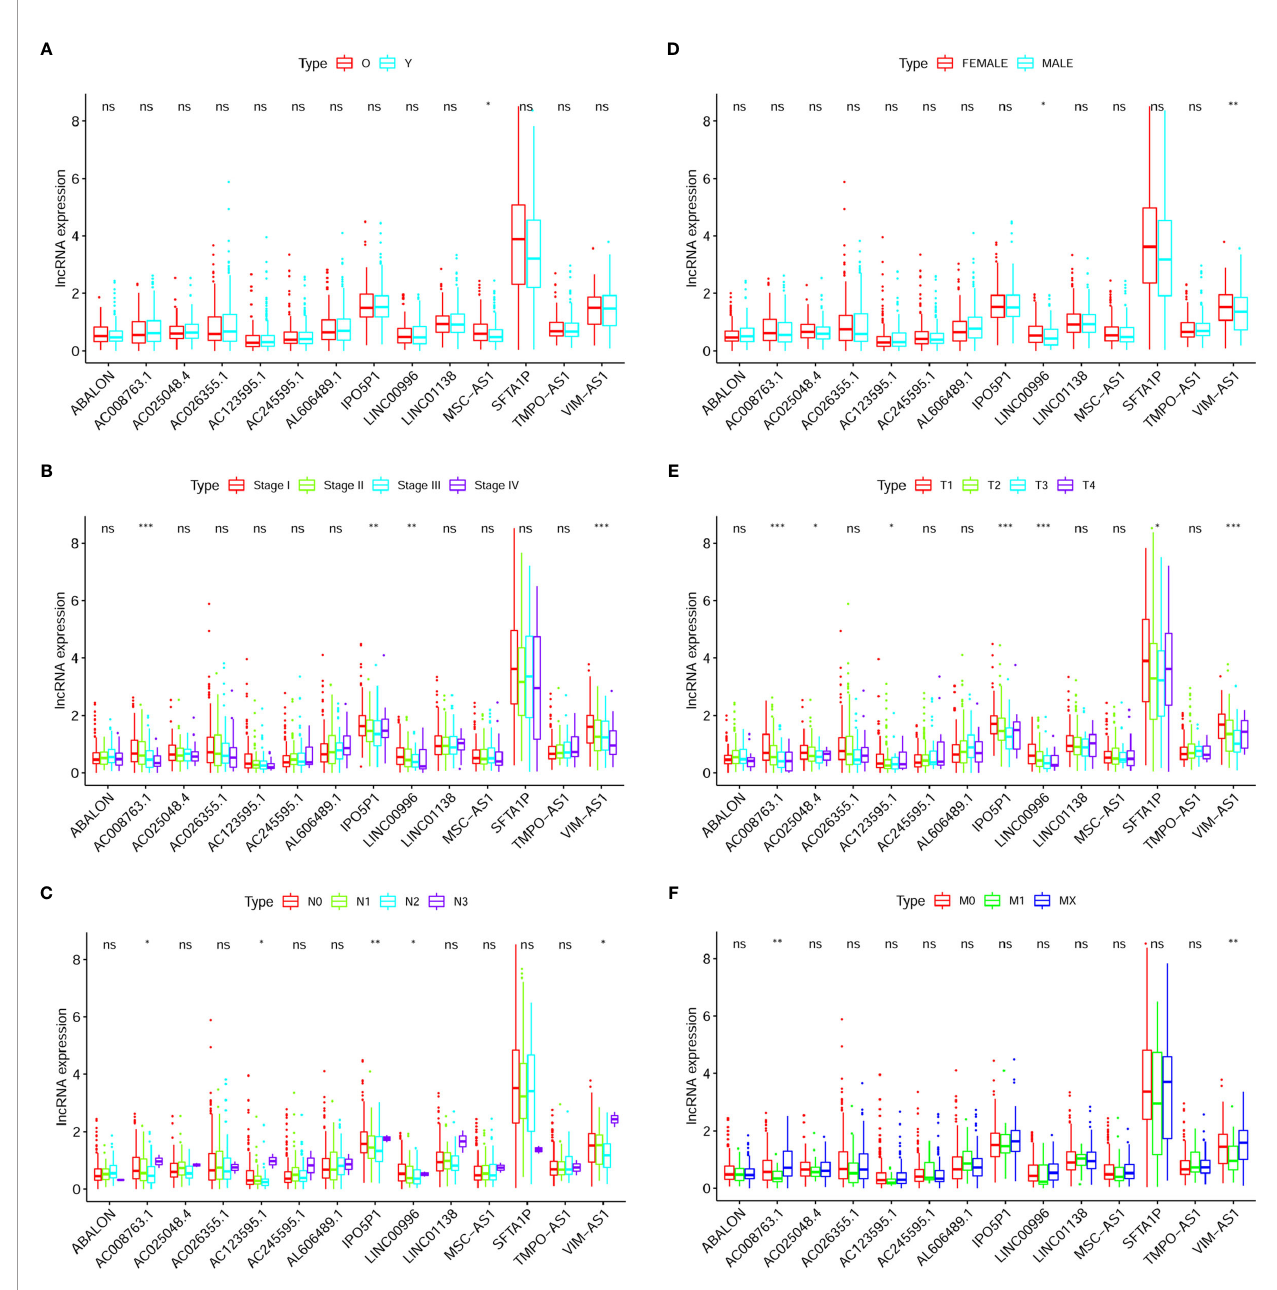
FIGURE 6 | Clinical correlation analysis between expression of LncRNA and prognostic factors of AD patients: Age (A) , Gender (B) , Stage (C) , T (D) , N (E) , M (F) . The “ * ” means that p < 0.05. The “ ** ” means that p < 0.01. The “ *** ” means that p < 0.001; ns, no signi fi